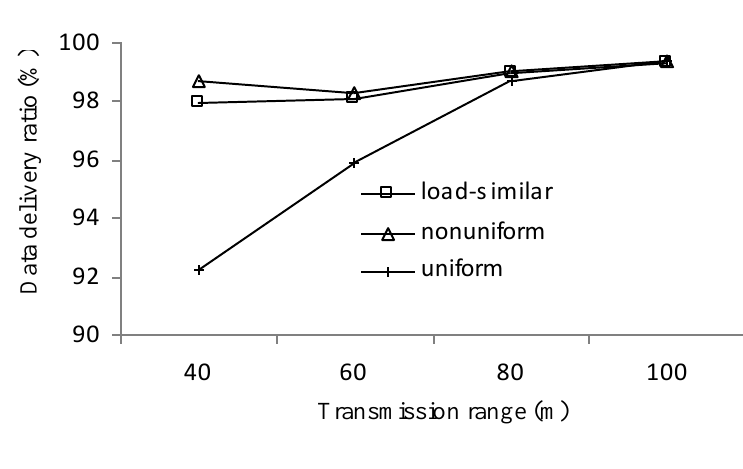
Figure 13. Data delivery ratio vs. r